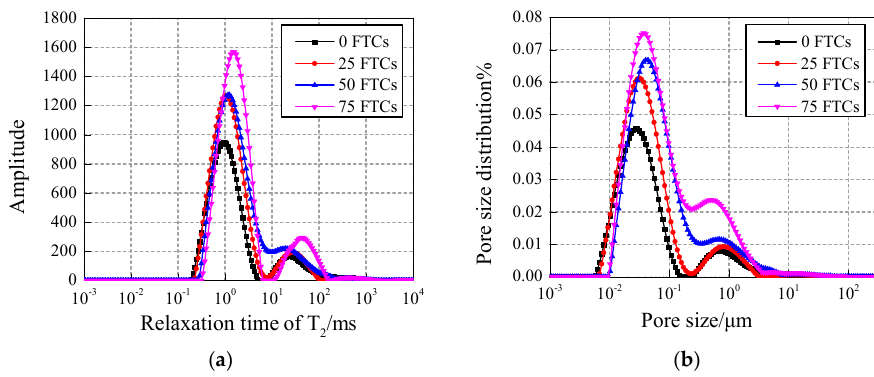
Figure 6. ( a ) T 2 spectrum and ( b ) pore fluid size distribution of the 15 nm-NS specimens. The curves of the 15 nm-NS and 30 nm-NS specimens show the trend of increasing peak point and right pendulum with the increase of freezing and thawing cycles, which indicates that the number, size, and volume of the pores in the specimen are increasing continuously.